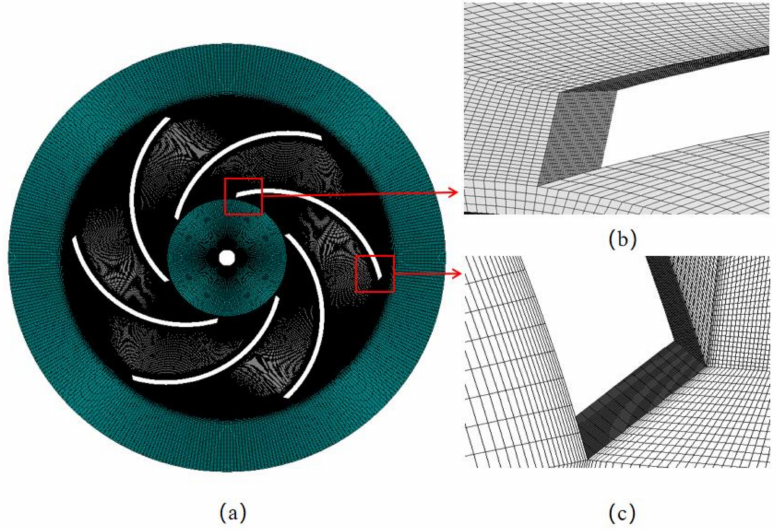
Figure 3. ( a ) Gird of the whole model; ( b ) enlarged view at the leading edge of the blade; ( c ) enlarged view at the trailing edge of the blade.